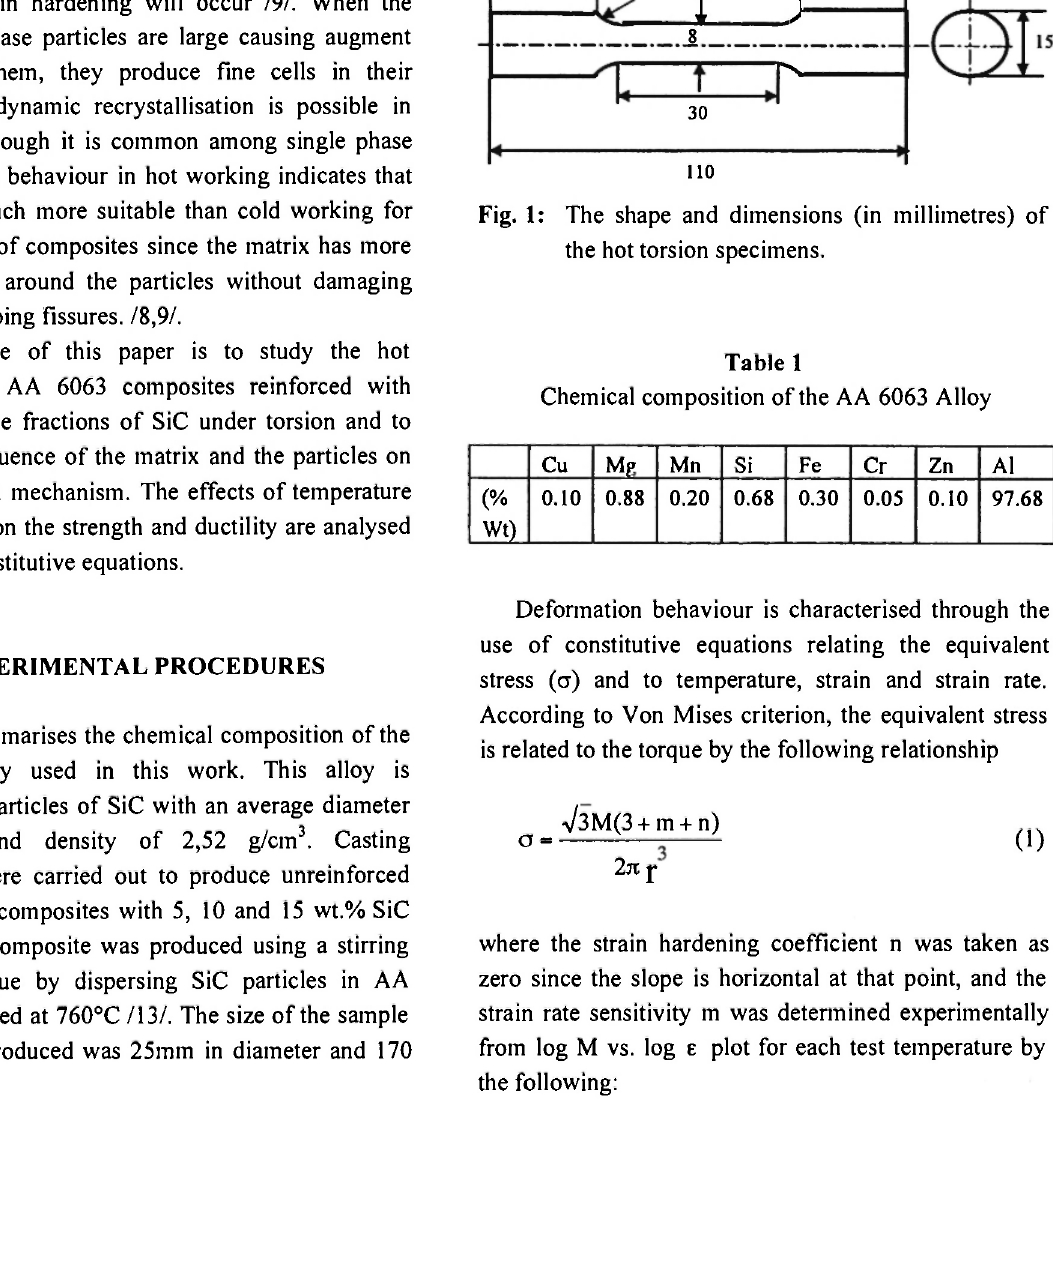
Fig. 1: The shape and dimensions (in millimetres) of the hot torsion specimens.